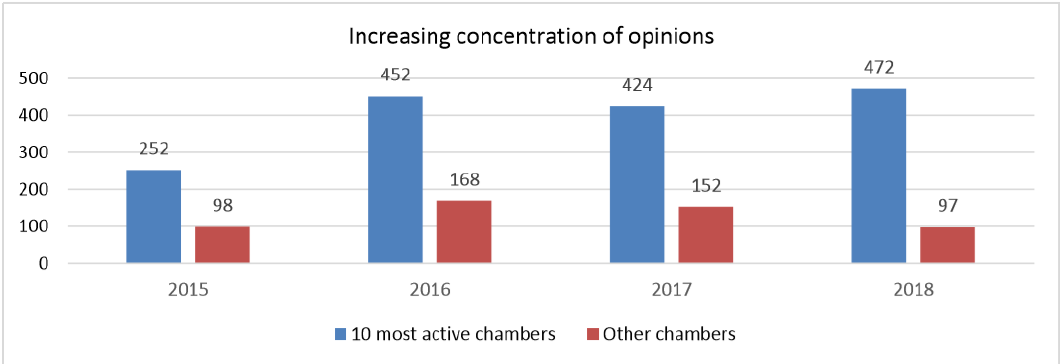
Figure 5. The number of opinions sent to the European Commission by the national parliaments (2015–2018). Source: European Commission (2019, p. 16).